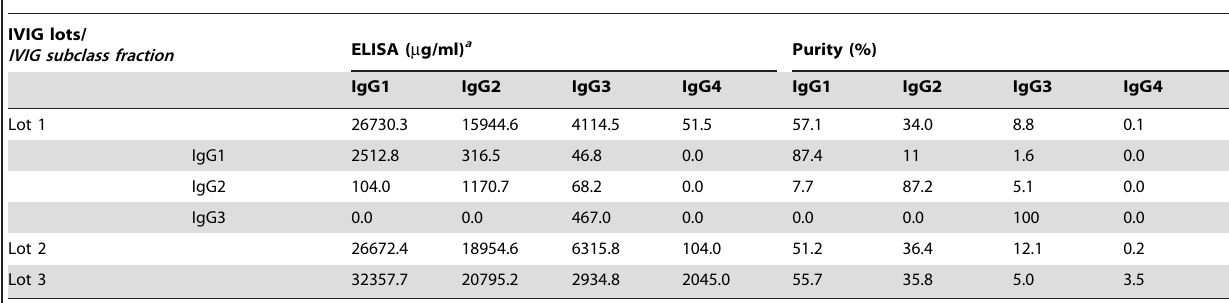
Table 1. Fractionation and purification of human IgG subclasses.